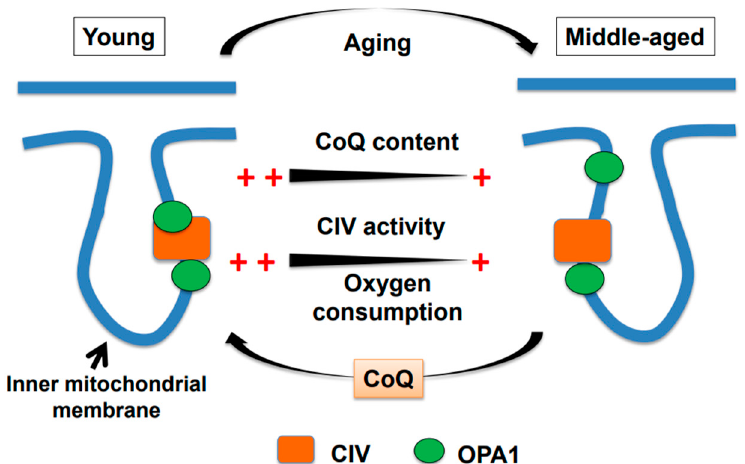
Figure 1. A graphical model of age-associated declines in brain mitochondrial function in male mice. The oxygen consumption rate (OCR) and cytochrome c oxidase activity of complex IV (CIV) and coenzyme Q (CoQ) levels are significantly lower in middle-aged mice than in young mice. Concomitantly, the amount of 95-kDa OPA1 bound to CIV is also lower in middle-aged mice. All of these age-associated alterations are restored by the administration of exogenous water-soluble CoQ10 to middle-aged mice.